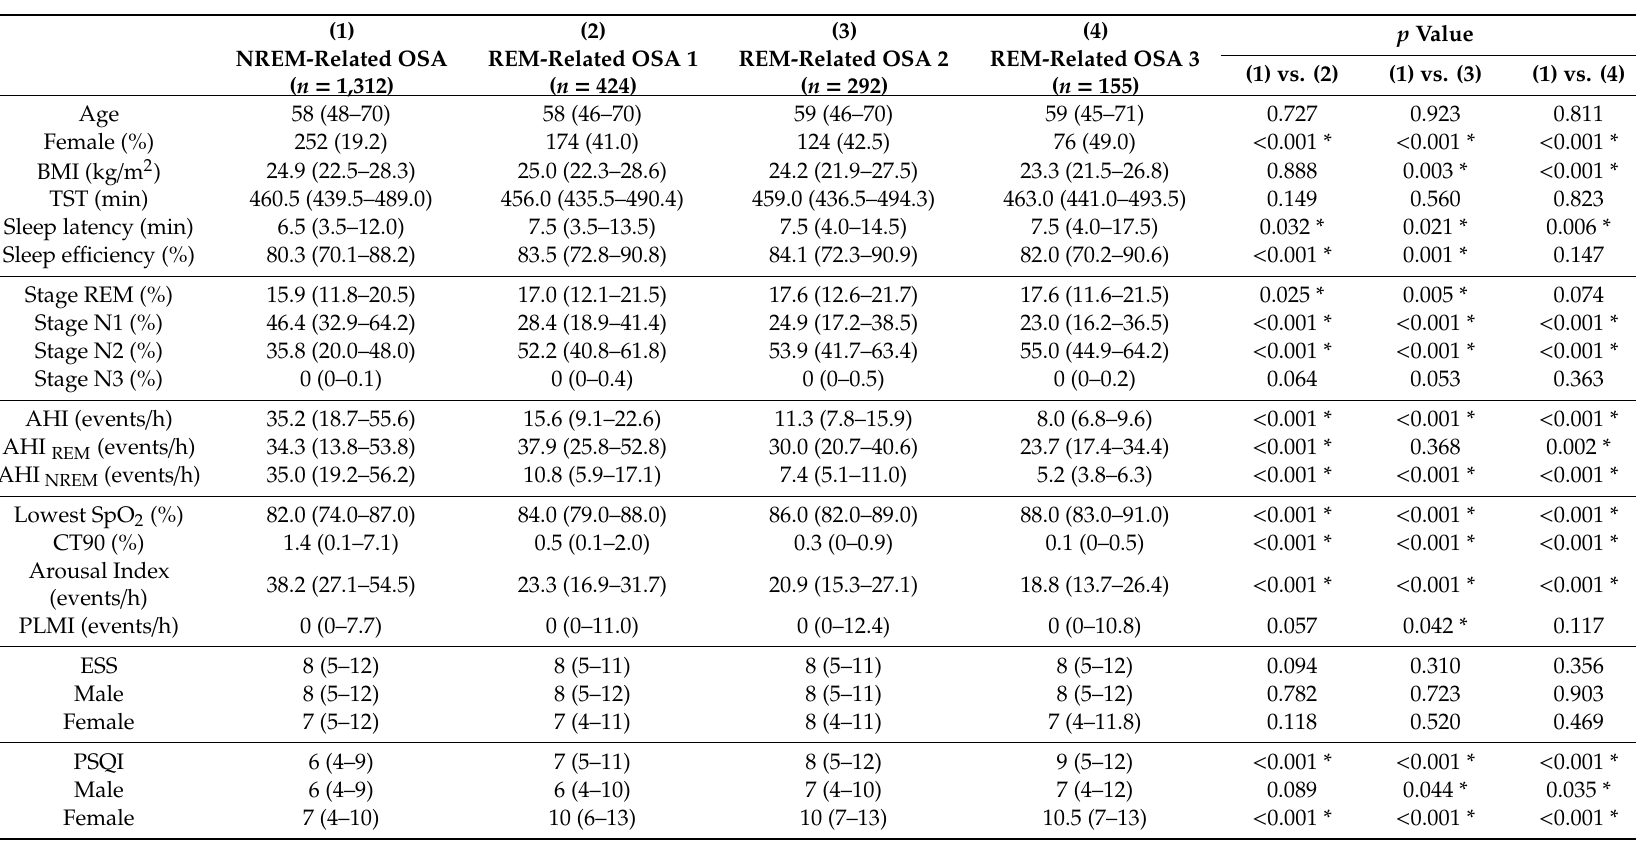
Table 1. Comparison of clinical characteristics and polysomnographic findings between patients with REM-related OSA and those with NREM-related